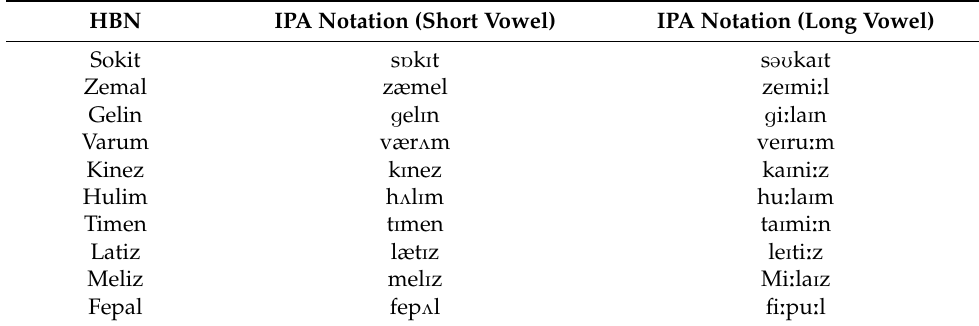
Table A1. Hypothetical Brand